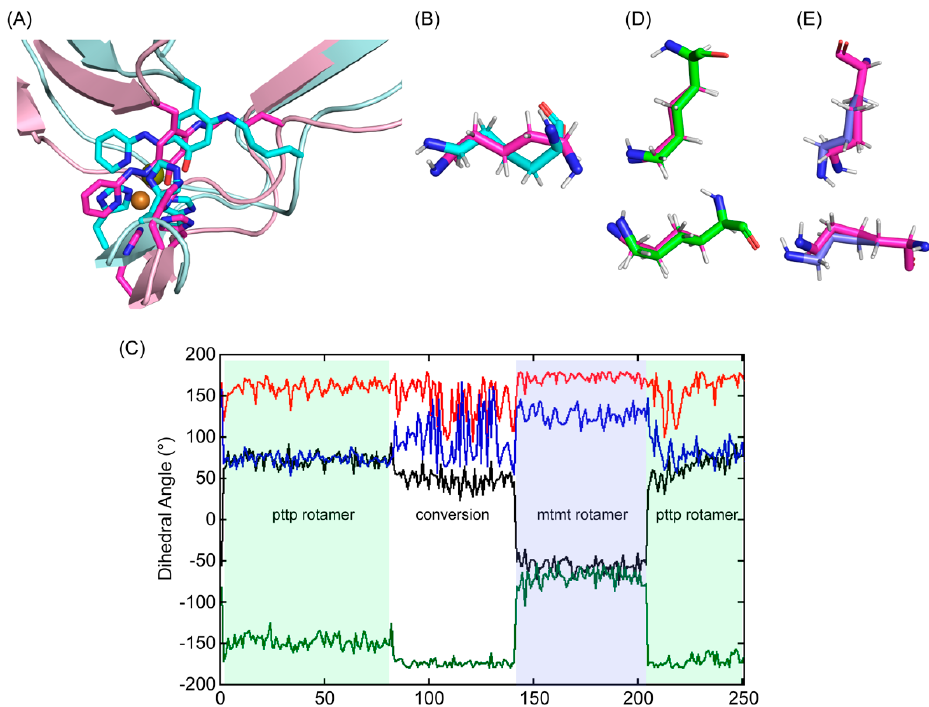
Figure 6. Molecular modeling and energy minimization of 2HP − inhibited Δ 1 − 2SRCR − LOXL2 in comparison to the structure after MD − simulation. ( A ) The initial 3D − model (in cyan) was generated by replacing Tyr689 with DPQ − 2HP and crosslinking C2 with the ϵ − amino side chain of Lys653. The single bond between ϵ − nitrogen and δ− carbon of Lys653 and the aromatic ring of Tyr698 (LTQ − 2HP) was not on the same plane (dihedral angle = 15°) and the − (CH 2 ) 4 − NH − side chain of Lys653 was in a higher energy conformation. After manual rearrangement of the hexapeptide (His652 − Lys653 − Ala654 − Ser655 − Phe656 − Cys657) and subsequent MD − simulation, the –(CH 2 ) 4 –NH– side chain of Lys653 was in a more relaxed conformation (in magenta and light pink). ( B ) An overlaid view of Lys653 in the initial 3D–model (in cyan) and in the final structure after MD–simulation (in magenta) ( C ) Dihedral angles of Lys653 during the 10 ns MD–simulation (40 ps/frame):